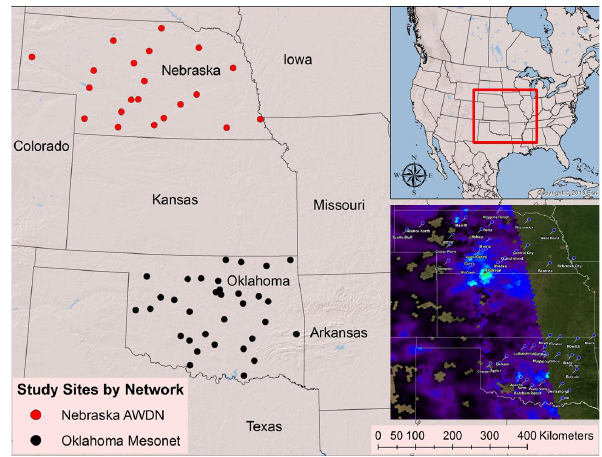
Figure 1. Soil moisture stations from the Nebraska Automated Weather Data Network and Oklahoma Mesonet that are used in this study. Automated Weather Data Network sites are red and Oklahoma Mesonet sites are dark blue. The lower right inset map shows a representative SMOS footprint from June 6, 2011 and the locations of stations in Oklahoma and Nebraska.